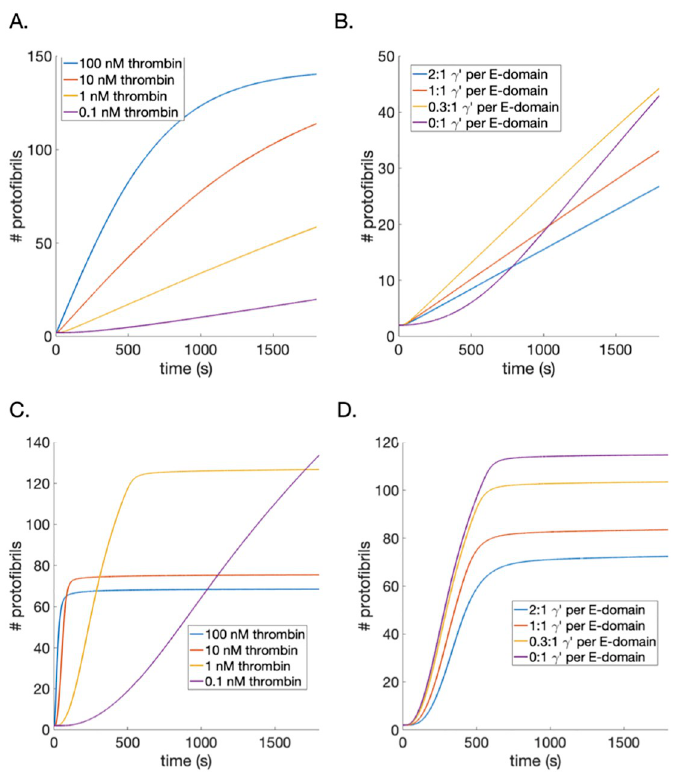
Fig 4. Number of protofibrils per fiber during polymerization. Model output for protofibril number as a function of thrombin concentration and ratio of γ 0 :E-domains. Varying thrombin concentration, 0.1 nM —purple, 1.0 nM — yellow, 10 nM —red, 100 nM —blue, using previously published parameters. B) The ratio γ 0 binding sites to fibrin (ogen) monomers (0:1—purple, 0.3:1—yellow, 1:1—red, and 2:1—blue) is varied and model uses previously-published parameters. Varied thrombin from 0.1 nM —purple, 1.0 nM —yellow, 10 nM —red,100 nM —blue, (C) and varied ratio of γ 0 binding sites to fibrin(ogen) monomers, from 0:1—purple, 0.3:1—yellow, 1:1—red, and 2:1—blue, (D) from the model evaluated with best-fit